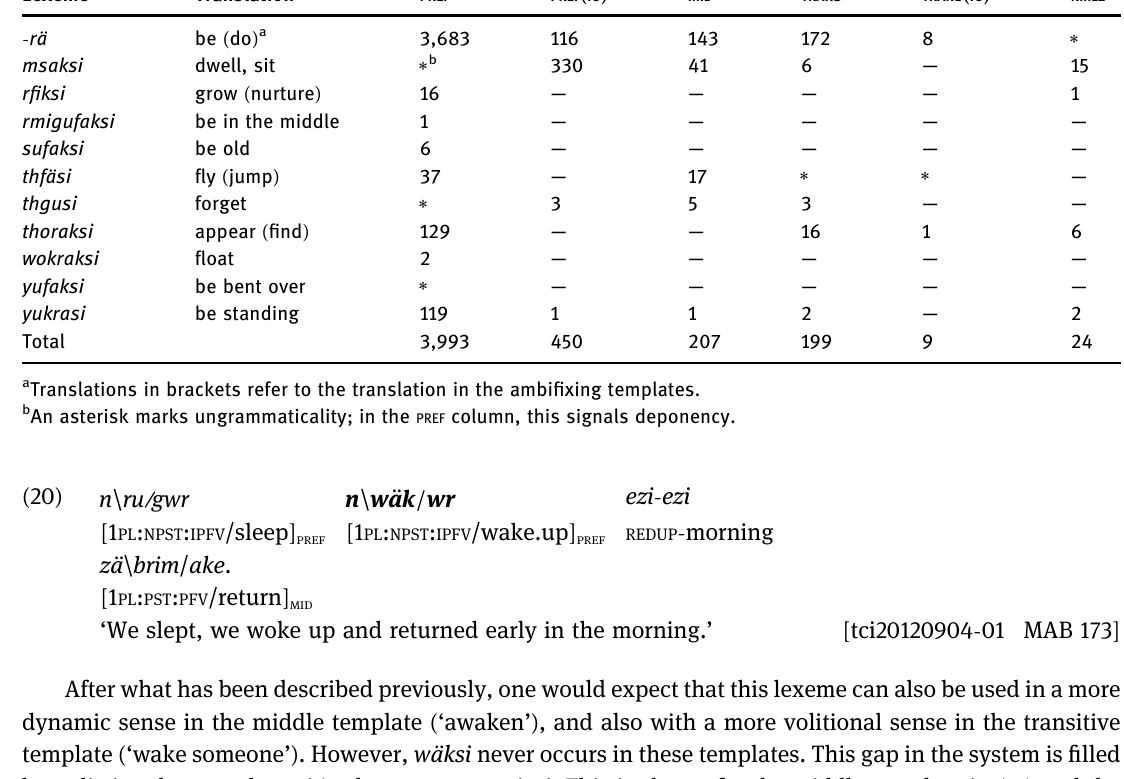
Table 5: Fluid pre fi xing verbs: non - positionals Lexeme Translation PREF PREF ( IO ) MID TRANS TRANS ( IO ) NMLZ - rä be ( do ) a 3,683 116 143 172 8 ∗ msaksi dwell, sit ∗ b 330 41 — 15 r fi ksi grow ( nurture ) 16 — — — — 1 rmigufaksi be in the middle 1 — — — — sufaksi be old 6 — thfäsi fl y ( jump ) 37 thgusi forget ∗ 3 thoraksi appear ( fi nd ) 129 wokraksi fl oat yufaksi be bent over yukrasi be standing 119 Total a Translations in brackets refer to the translation in the ambi fi xing templates.